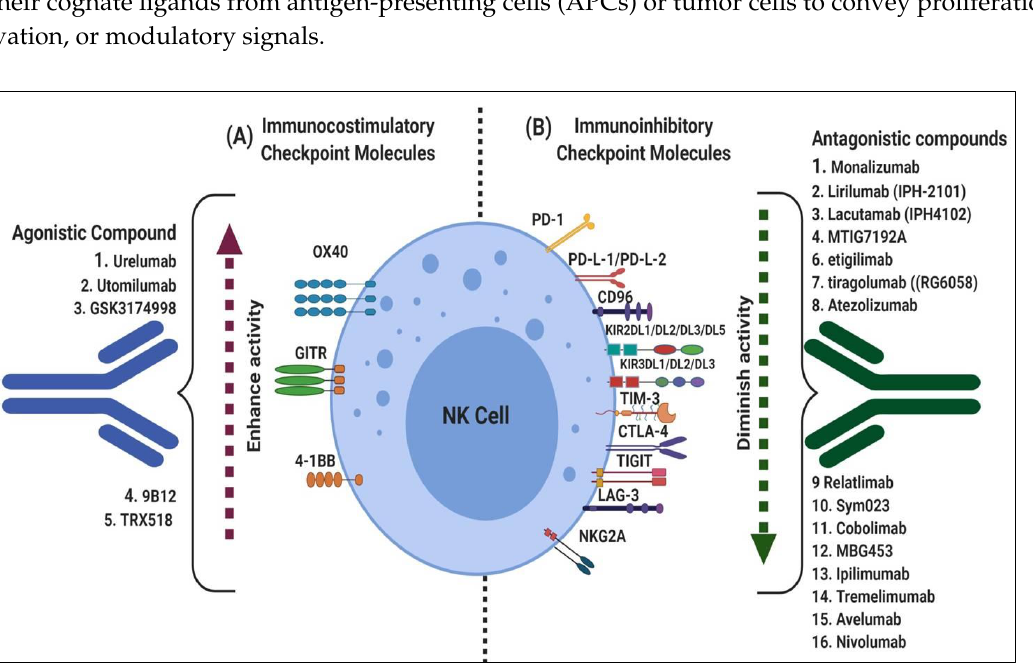
Figure 3. Immune-checkpoint molecules keep balance of the immune system: ( A ) Immunocostimulatory checkpoint receptors responsible for the enhanced immune cell proliferation, survival and activation and agonistic compound fully activates the receptor that it binds; ( B ) Immunoinhibitory checkpoint molecules diminish cell cytotoxic potential and prevent their antitumor functions and antagonistic compound that binds to a receptor but does not activate.